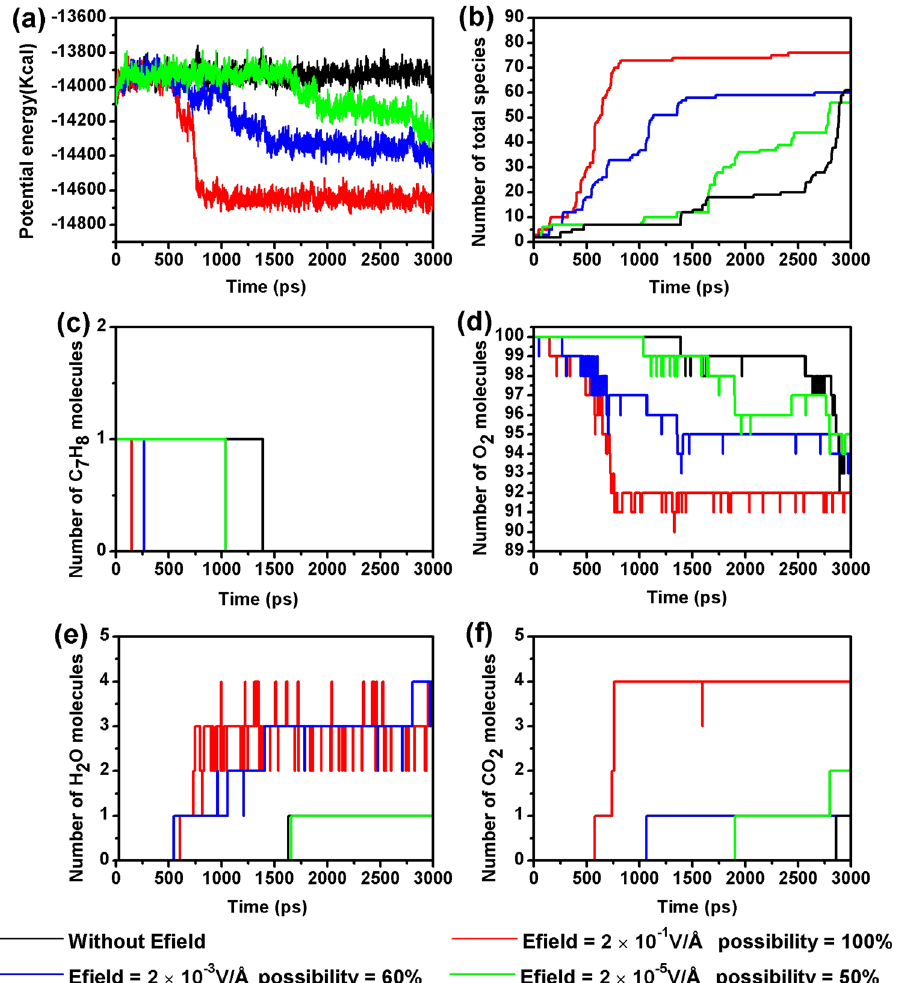
Figure 5. Evolution of the potential energies, total number of species, toluene, oxygen and main products at Efield = 2 × 10 − 1 , 2 × 10 − 3 , 2 × 10 − 5 and 0 V/Å (ReaxFF NVT-MD simulation, ρ = 0.35 g/cm 3 , T = 2500 K, toluene/oxygen =